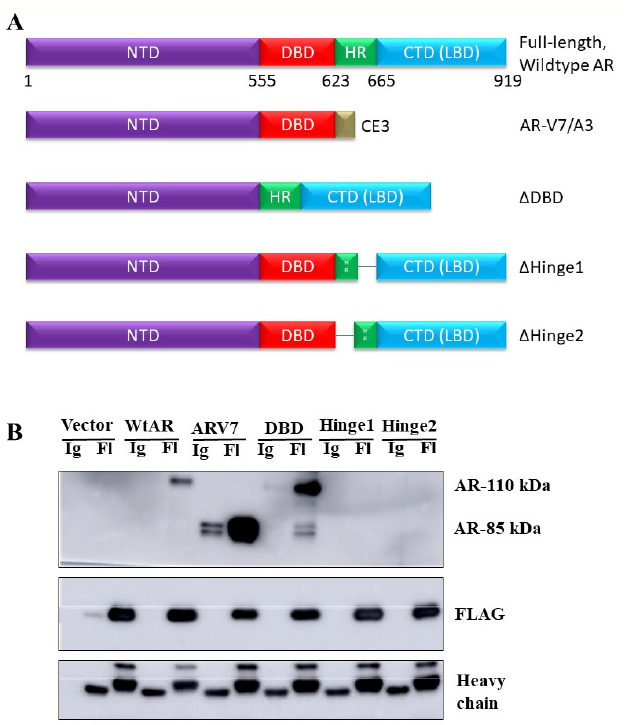
Figure 6. The interaction between NRDP1 and the androgen receptor is dependent on the hinge domain of the androgen receptor. Four androgen receptor (AR) constructs were used to validate the interaction between AR and NRDP1 and to help determine which regions of AR are involved in mediating the interaction; AR V7 (lacks the ligand binding domain (LBD)), Δ DBD (lacks the DNA binding domain (DBD)), Δ Hinge 1 and Δ Hinge 2 (both constructs lack the hinge region) ( A ). Co- transfection of PC-3 cells (which lack endogenous AR) with the AR constructs and the FLAG-tagged NRDP1-CSHQ construct (3 µg per 100 mm dish, 72 h) followed by FLAG immunoprecipitation and western blot confirmed that interaction between AR and NRDP1 is possible ( B ) pulldown of both the ARV7 and DBD AR constructs was observed. Pulldown of the Hinge constructs was not observed indicating that interaction between AR and NRDP1 may occur via the AR Hinge domain. Detailed information about Western Blot can be found at supplementary